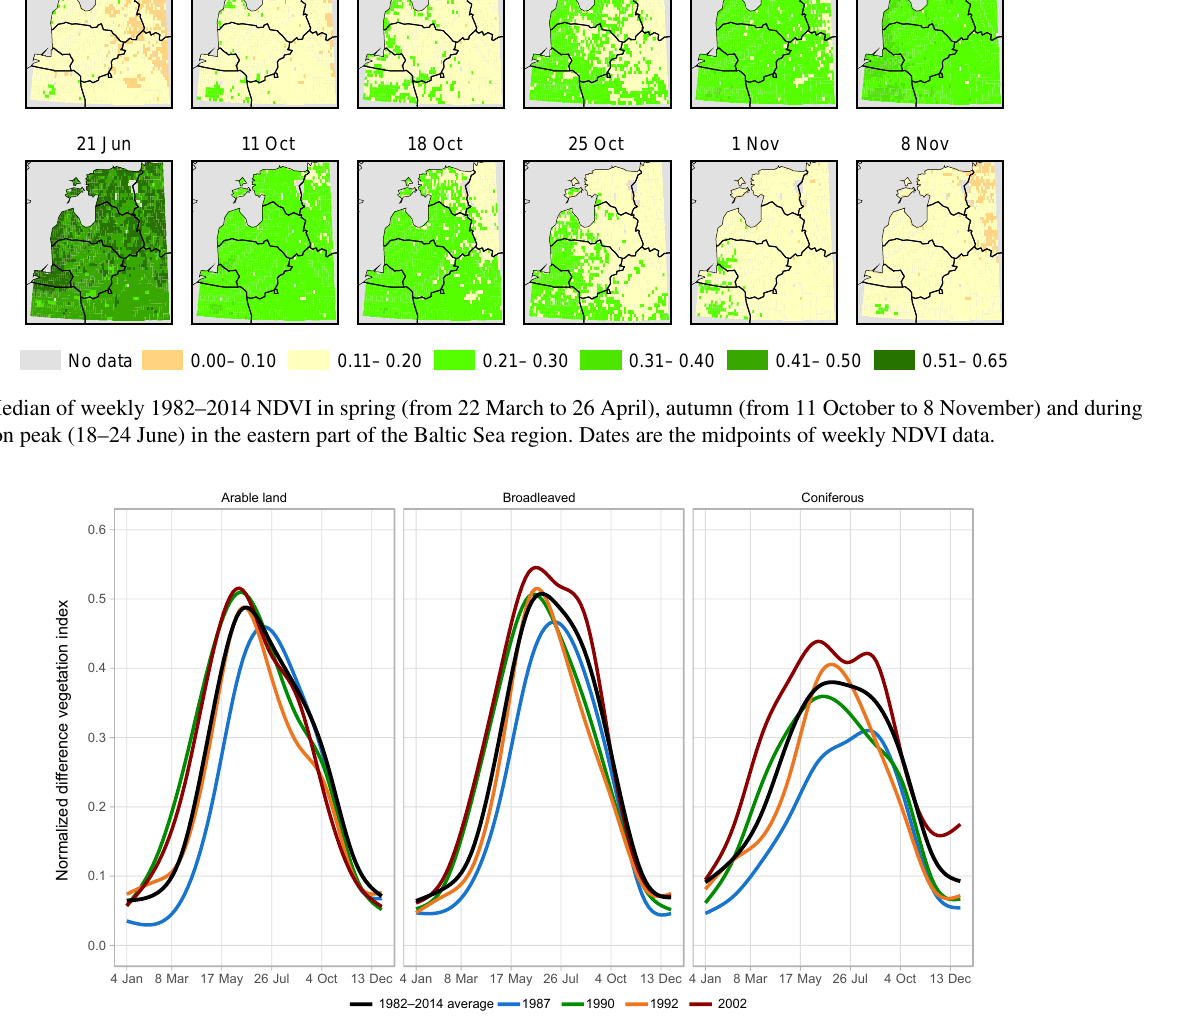
Figure 3. NDVI profile for different land uses of multi-annual average (1982–2014) years with cold (1987), warm (1990), winter and spring seasons, and during the years with a precipitation deficit (1992,